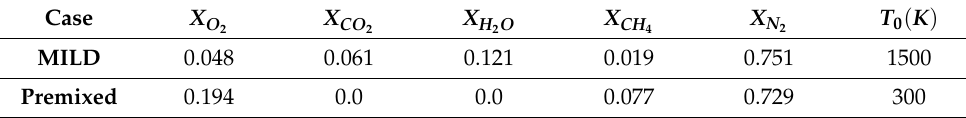
Table 1. Thermochemical conditions.